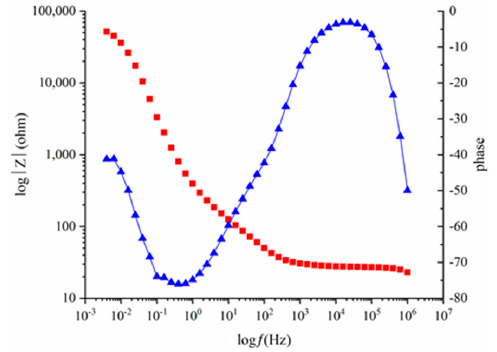
Figure 4. Bode curves of type-2205 duplex stainless steel in 0.5 M NaCl